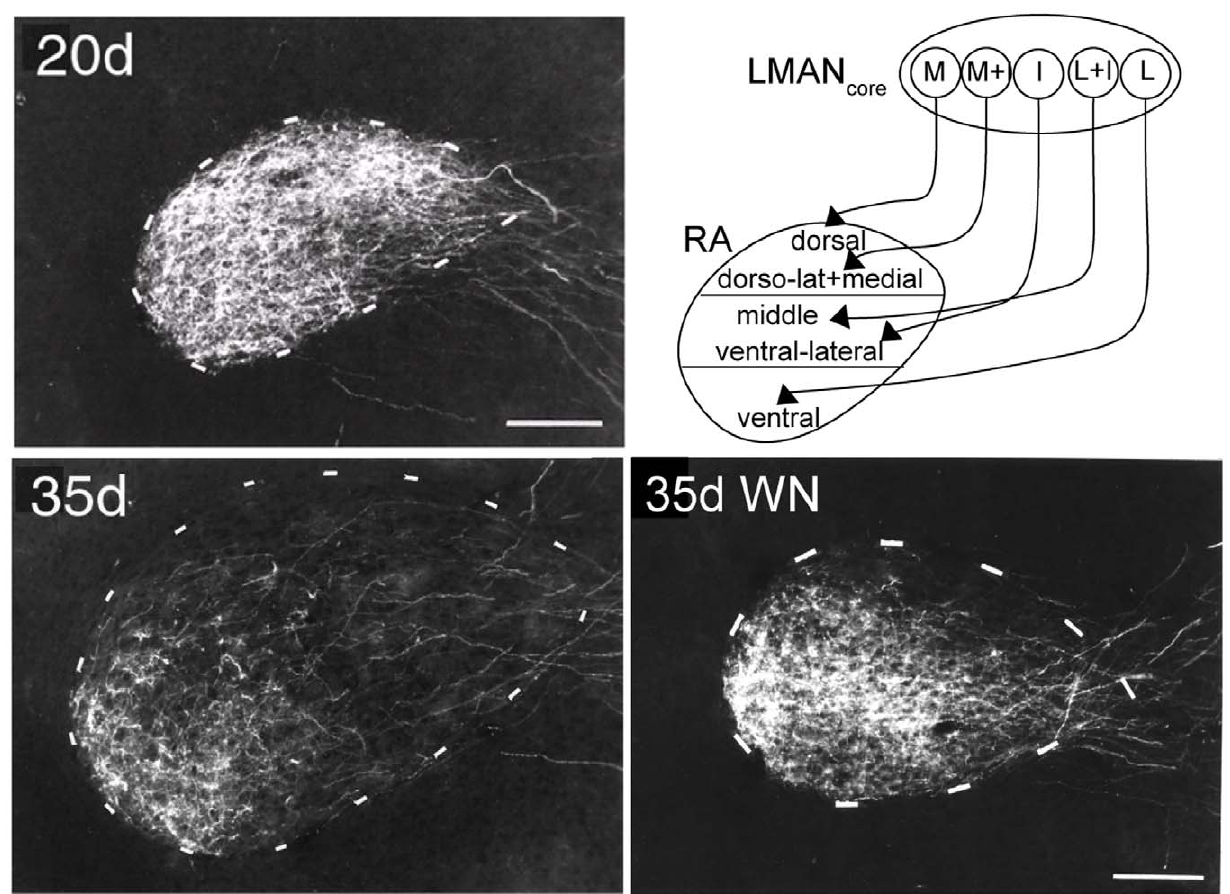
Figure 1. Remodeling of the axonal projection from a cortico-basal ganglia circuit to vocal motor cortex in zebra finches. The core region of LMAN (lateral magnocellular nucleus of the anterior nidopallium) provides the cortical outflow of a basal ganglia circuit necessary for vocal form learning to vocal motor cortex (RA, robust nucleus of the arcopallium). Previous work from our lab has shown that the axons of LMAN CORE a precise topographic map in RA of adult birds (shown schematically in the upper right panel), which may represent a myotopic map of vocal muscles to RA has little or no topographic organization in 20-day and/or acoustic features or vocal sounds. However, the axonal projection from LMAN CORE spread throughout most of RA at this age birds at the onset of vocal learning (20 d, upper left panel): axons from small subregions of LMAN CORE axons of birds that receive normal auditory experience undergo substantial re-modeling to form a normal topographic [24,69]. However, LMAN CORE map by 35 days of age (35 d, lower left panel) [24]. In contrast, this axonal remodeling is prevented in juvenile birds that are raised in constant white noise [24]. This remodeling is due to both pruning and re-positioning of individual axons, including both genetic and experience-dependent changes in neural connectivity during the first two weeks of vocal learning [25]. Scale bars=200